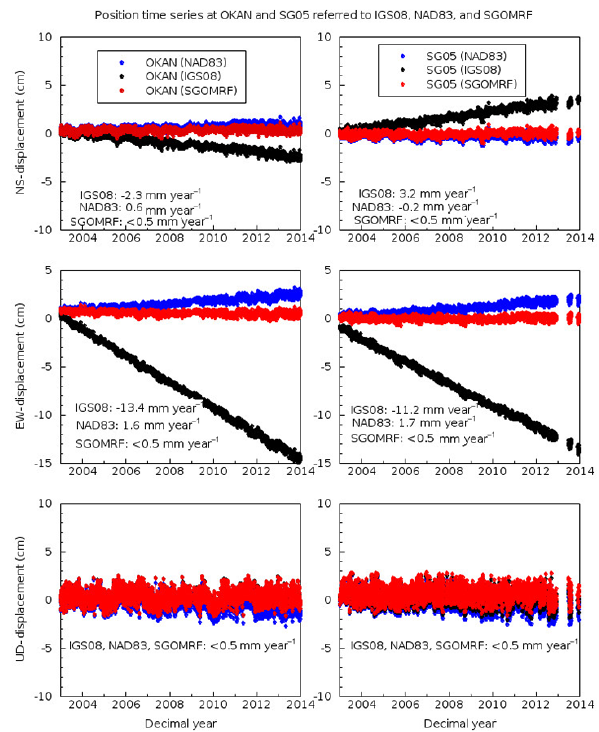
Figure 3. Comparisons of time series at two CGPS sites, OKAN and SG05, referred to three reference frames: IGS08 (black), NAD83 (blue), and SGOMRF (red). OKAN is located at Antlers, Oklahoma. SG05 is located at Melbourne,